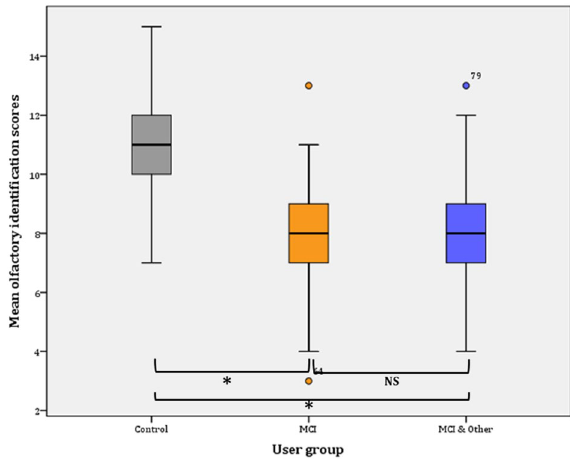
Figure 5. Mean olfactory identification scores (Phase